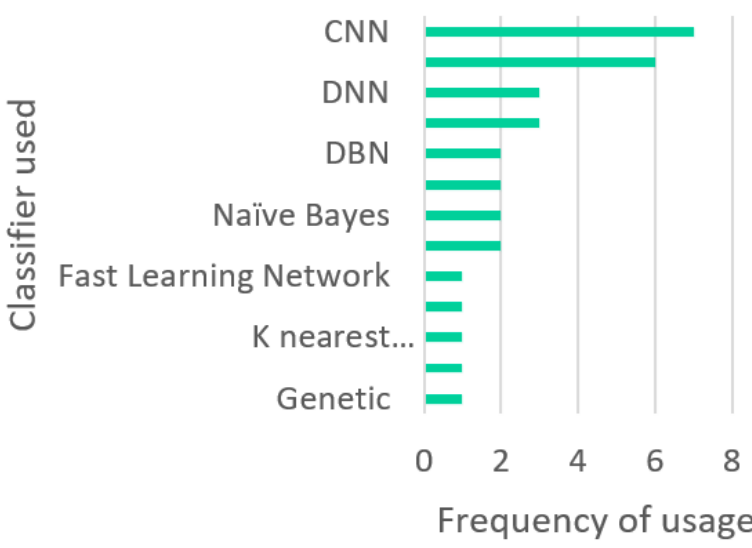
Figure 4. Frequency of Classifier used (Section